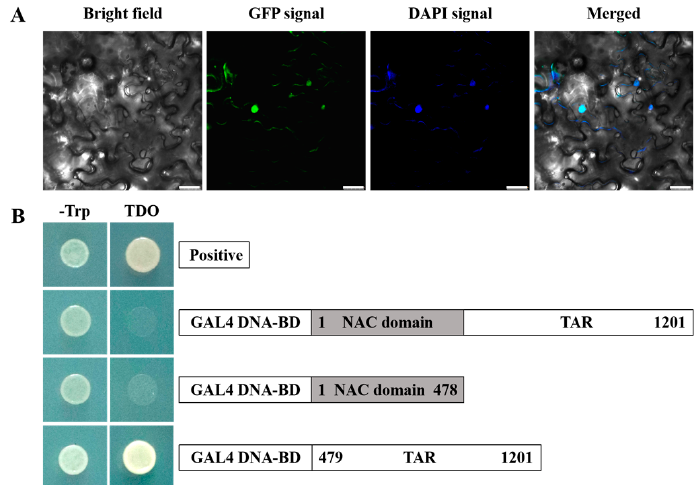
Figure 3. EjNACL47 is an NAC TF. ( A ) Subcellular localization of EjNACL47::eGFP. DAPI, 4 ′ ,6- diamidino-2-phenylindole dihydrochloride. Merged represents the merged images of bright field, eGFP, and DAPI signals. Scale bar, 25 μ m. ( B ) Analysis of EjNACL47 transcriptional activity. TAR, transcriptional activation region; positive, positive control (pGBKT7-p53); BD, pGBKT7 vector; TDO, triple dropout supplements (SD/-Trp-His-Ade).